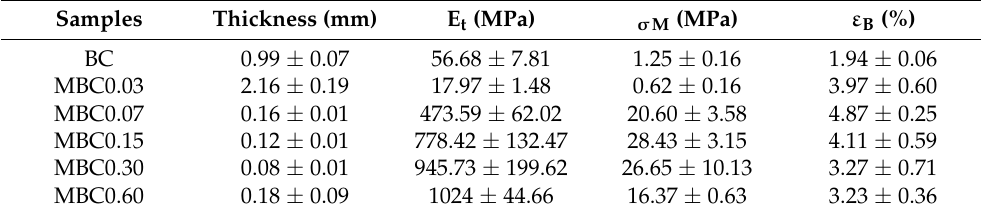
Table 2. Mechanical properties of the unmodified and modified samples as mean ± standard